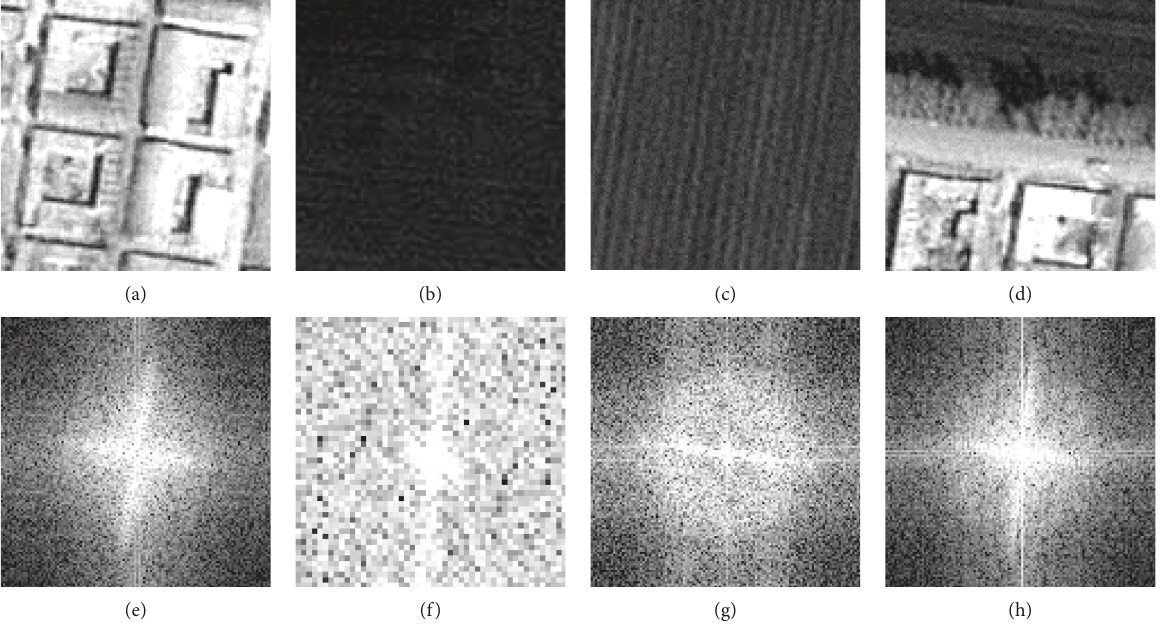
Figure 2: Four subset textures and their spectrum. (a) Houses. (b) Farmland_1. (c) Farmland_2. (d) Image covered with mixed features. (e)–(f) are the related spectrum feature images of (a)–(d).